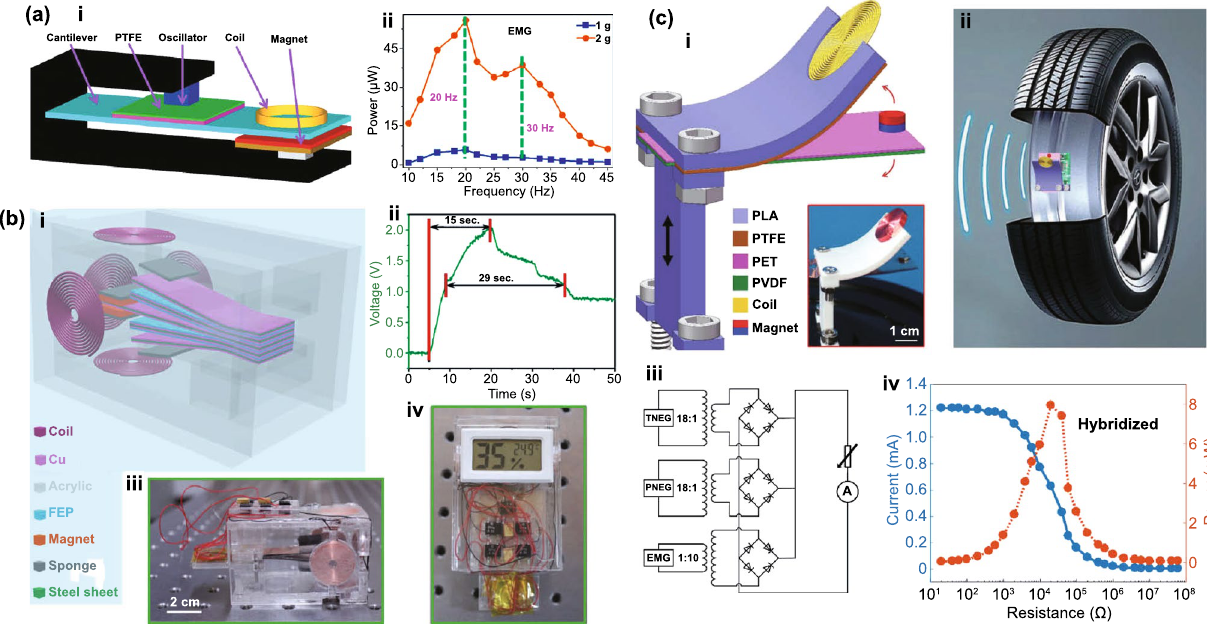
Fig. 24 a (i) 3D schematic view of the hybrid EMG and TENG multi-impact energy harvester designed by Zhu et al. (ii) Measurement power as a function of the frequency and two different excitation acceleration amplitudes for the EMG. Reproduced with permission from Ref.